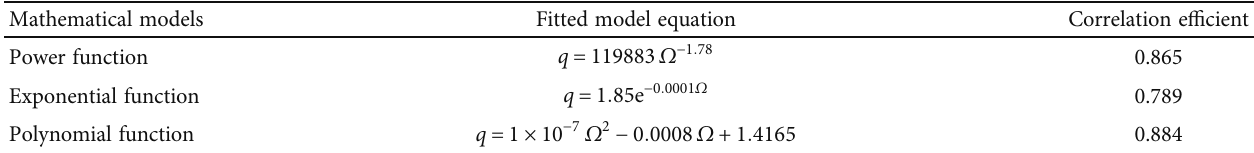
Figure 7: Borehole 2 comparison curves of electrical resistivity and Lugeon value results. Table 1: Model analysis table of the relationship between electrical resistivity and Lugeon value.